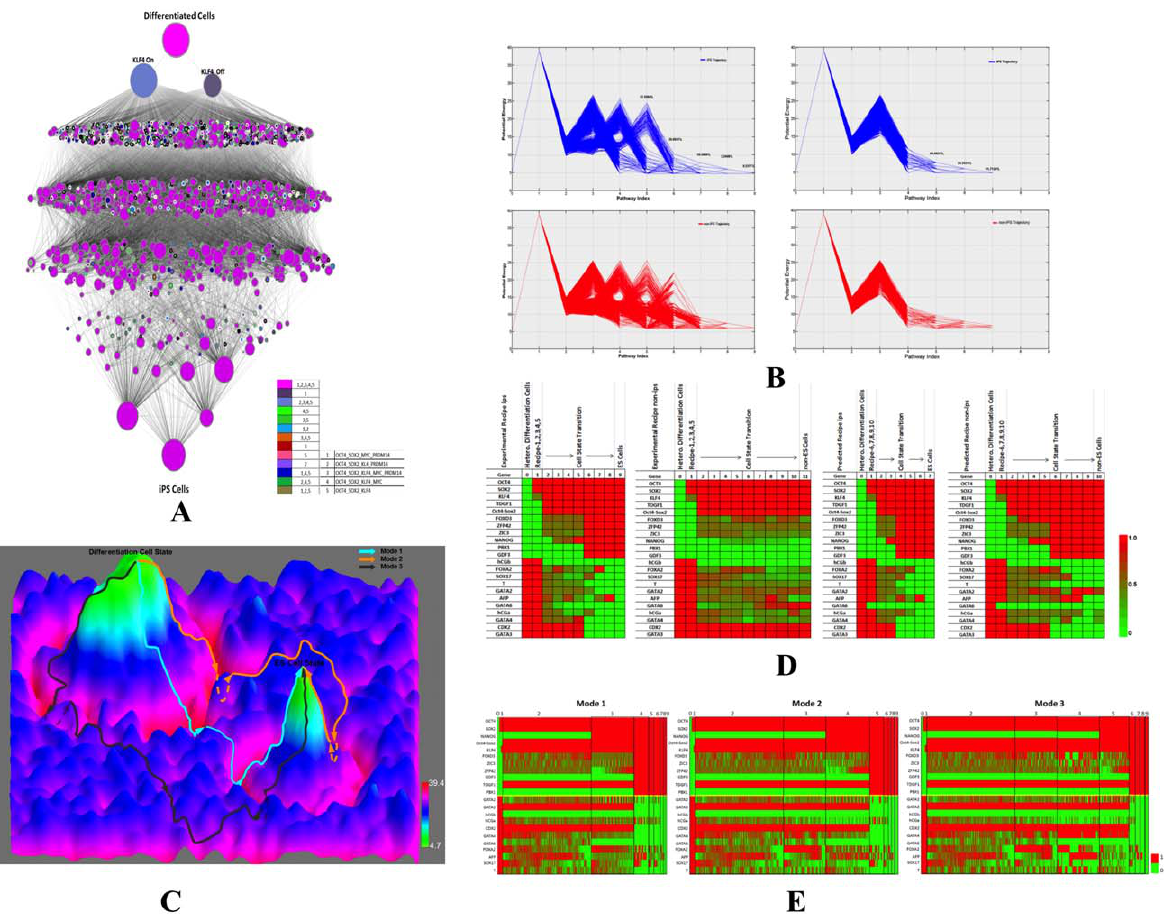
Figure 4. Reprogramming procedure. ( A ) . State transitions during iPSC generation by the five experimentally confirmed recipes (overexpression of OCT4, SOX2, KLF4, PRDM14, or MYC). Each recipe was sampled 100,000times. For illustrative purposes, each cell state was only defined by the 22 marker genes. The node size is proportional to the dynamical flux, which is defined as the number of paths going through the node. The color of nodes indicates the dynamical path of which experimentally validated recipes going through this node. Note that different reprogramming paths consist of a variable number of states, i.e. different paths pass through a variable number of nodes. ( B ) . Potential changes along the reprogramming paths by the five experimental recipes (left) and experimental recipes plus knockdown of GATA6 (right). Upper (blue lines) and lower (red lines) panels respectively show the paths that converged to the hESC and non-hESC attractors. The numbers indicate the percentages of initial states converged to the hESC attractors at the corresponding steps. X-axis values specify simulation step numbers. ( C ) . Schematic illustration of the three modes of reprogramming by the 5 experimental recipes (Table 1) on the potential landscape (upside down of Figure 1). The z-axis specifies the potential energy of a cell state and each cell state is specified by x- and y-coordinates. Mode 1 represents the most efficient (shortest) reprogramming paths spent least steps, mode 2 represents (moderate length) reprogramming pathways spent one extra steps in the valley, and mode 3 represents the least efficient (longest) reprogramming pathway with two extra steps in the valley. ( D ) . Gene expression changes of marker genes during reprogramming. As the simulation progresses, the hESC marker genes are down regulated while the differentiation marker genes are up regulated. The gene expression colors represent averaged values at each step. This analysis was based on experimentally validated reprogramming recipes. ( E ) . Expression of marker genes in the three modes of experimentally validated reprogramming recipes. Each column represents a unique state. The width of each simulation step (from initialization at step 0 to the converged joint probability at step 9) during reprogramming is proportional to the number of distinct cell states at that step: the larger the width, the more distinct cell